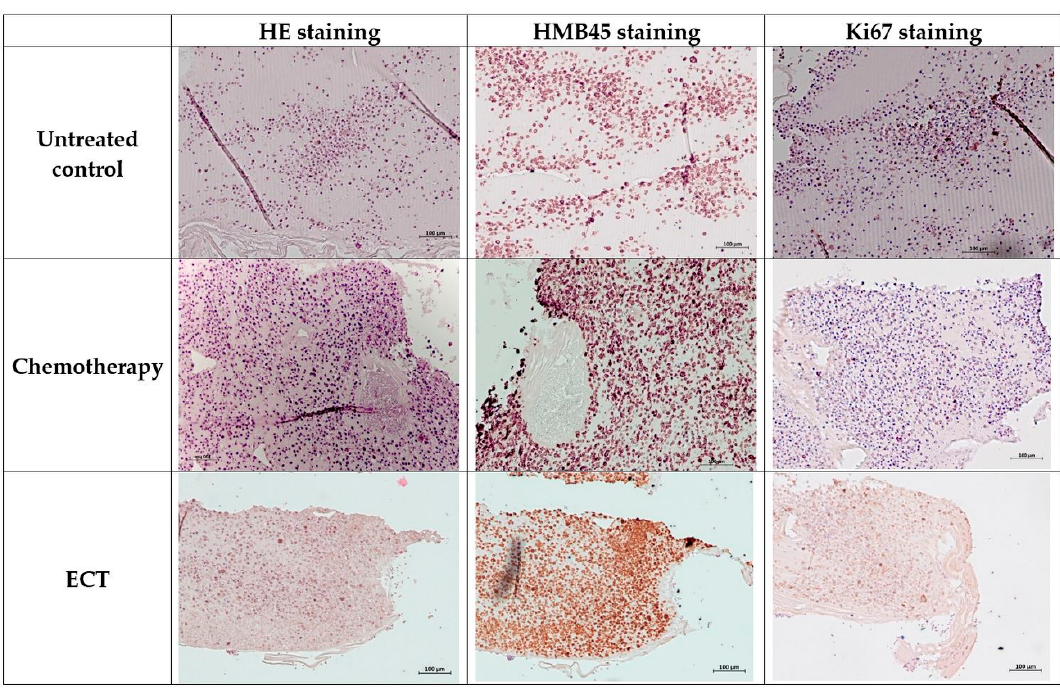
( c ) overview of CAM including human UM cells, viability of human UM cells were controlled using hematoxylin and eosin staining (HE staining); ( d ) PAS staining of central CAM section; the majority of invading 92.1 cells were necrotic (negative for hematoxylin); ( e ) overview of CAM including human UM cells; proliferating 92.1 were immunohistochemically labeled with antihuman Ki67 marker (in brown); ( f ) Ki67 labeling of central CAM section (in brown), peripheral proliferating cells, central Ki67 negative cells. Abbreviation: AC = apoptotic cells, CI = cancer cell invasion, ED = Chorionic ectoderm, MD = chorionic mesoderm, MG = Matrigel graft, NC = necrotic cells, PC = proliferating cells, VA =